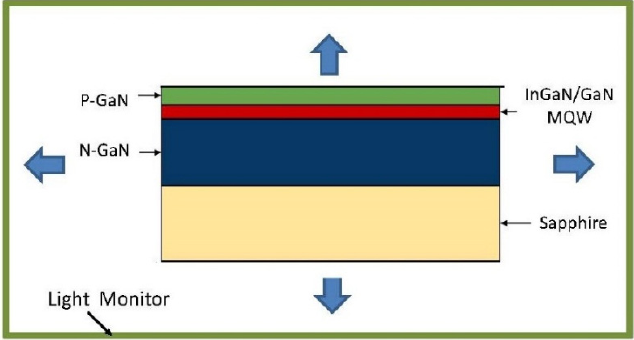
Figure 1. Structure and basic simulation model of conventional Gallium nitride (GaN) based light-emitting-diode